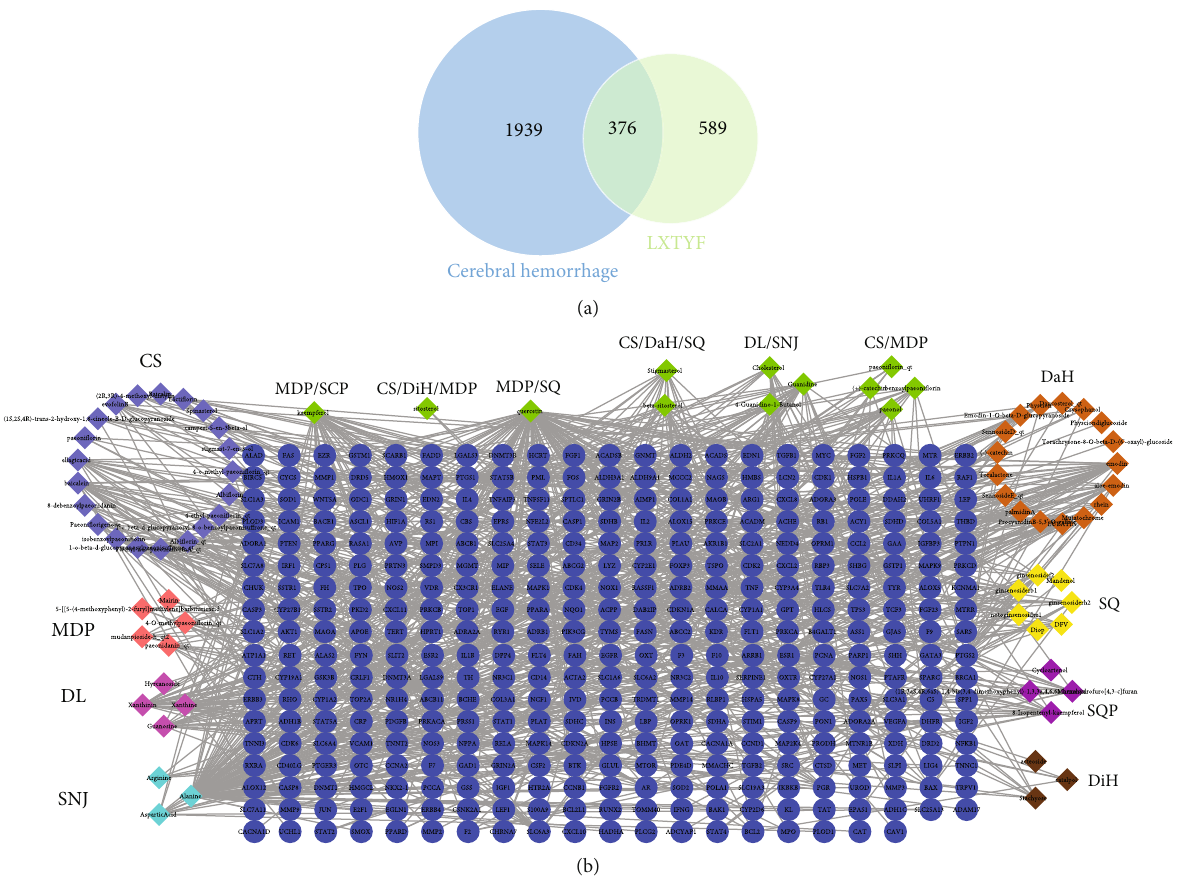
Figure 2: Network construction. (a) Veen diagram describing targets distribution of LXTYF and ICH. (b) The network of Putative Component-Target. Blue ellipses refer to 376 targets of LXTYF for AICH treatment. Di ff erent color triangles represent 76 active components in LXTYF. In particular, green triangles stand for common compounds of three and two